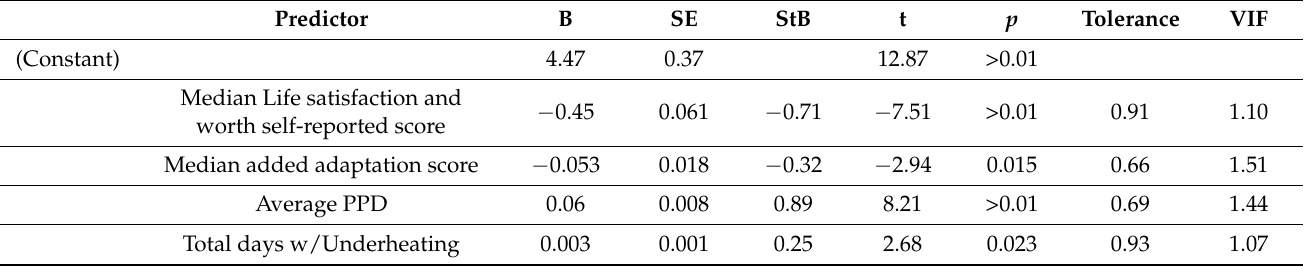
Table 12. Best-fit final stepwise linear regression (backward) model with average total self-reported